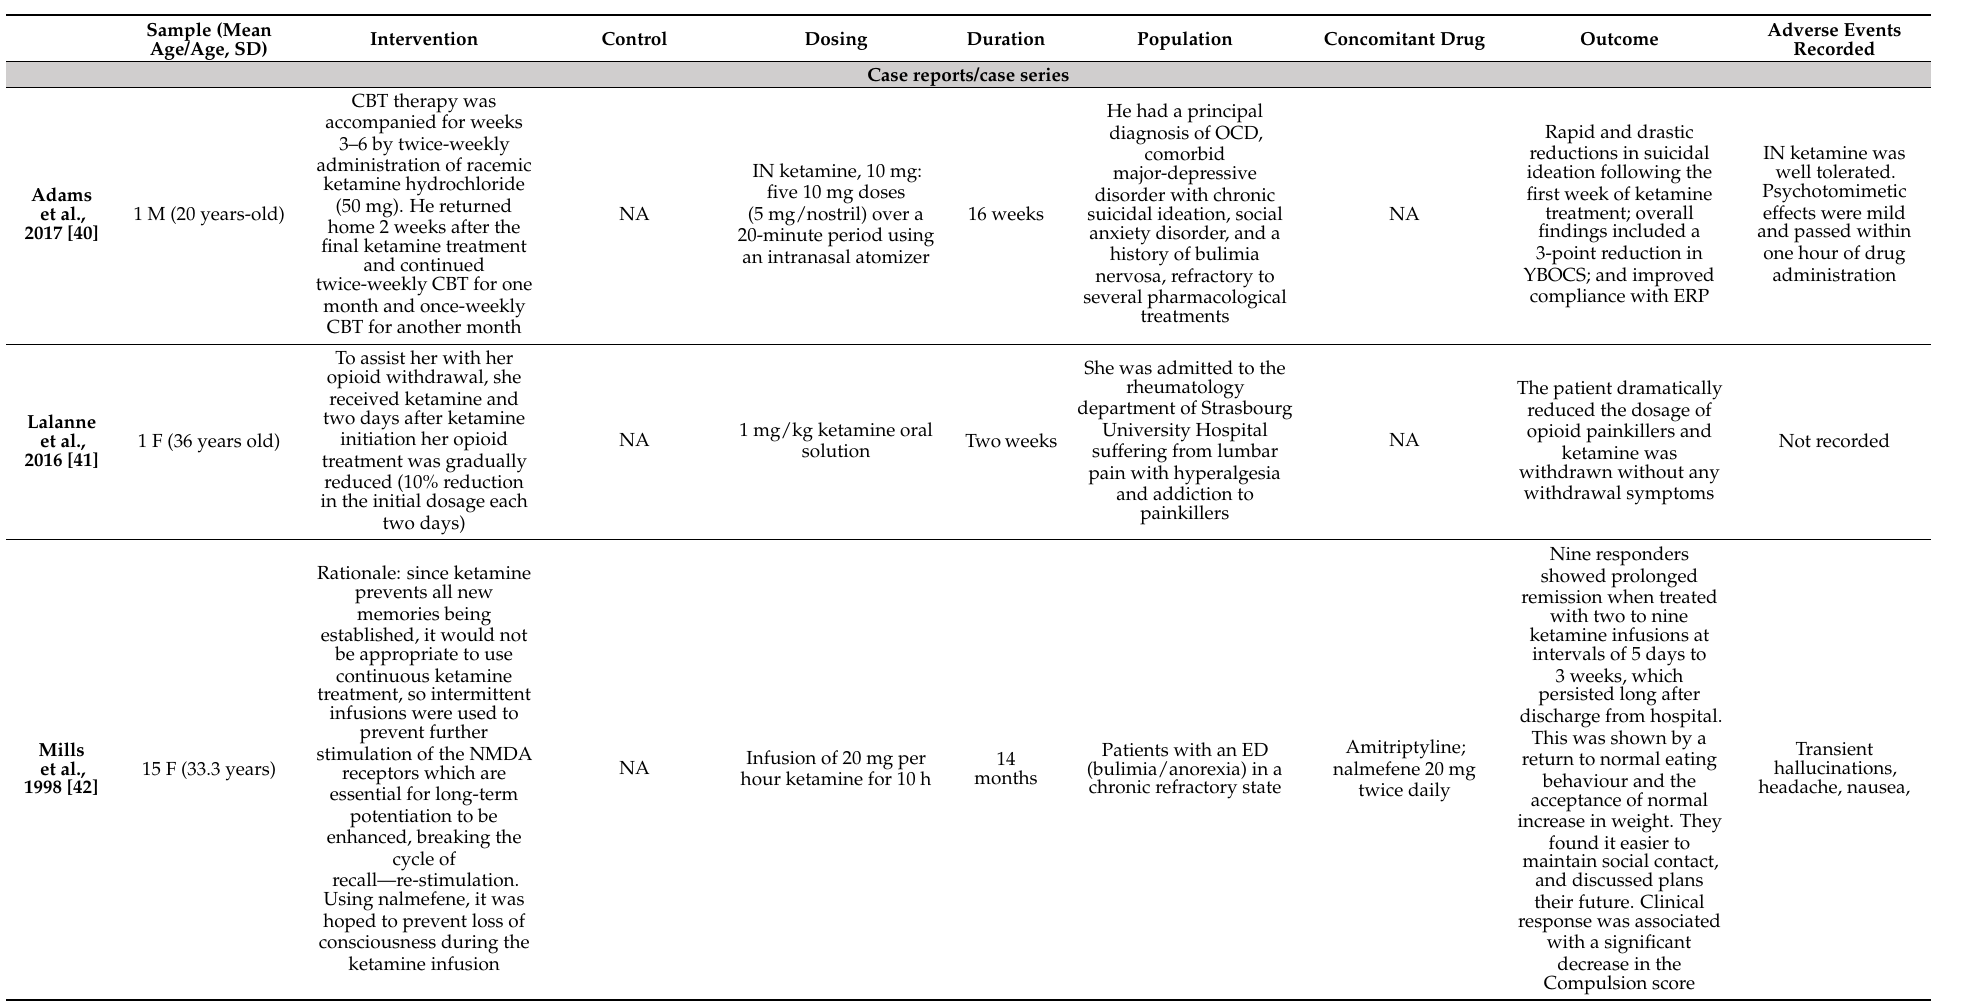
Table 1. Main findings of retrieved